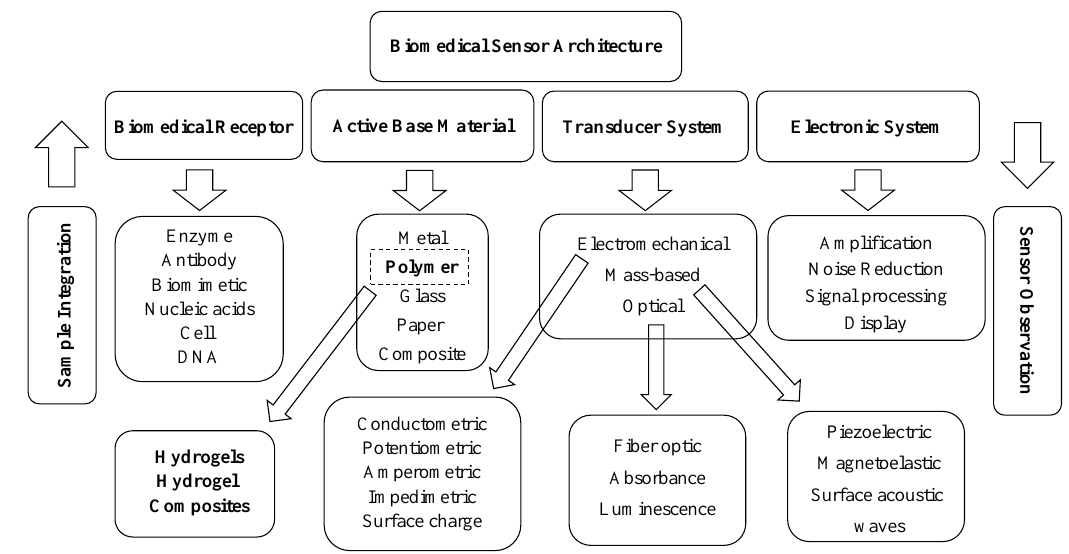
Figure 7. Overall schematic of a hydrogel-based sensor architecture. Concept adapted with permission from